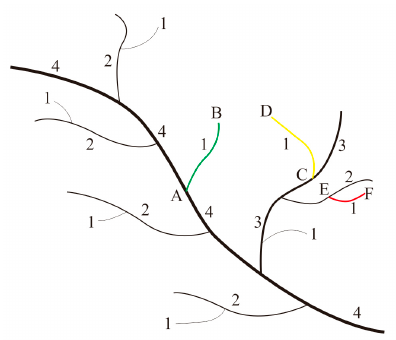
Figure 3. Inadequacies of top-down coding methods: three streams (AB, CD and EF) with different levels have the same code one.